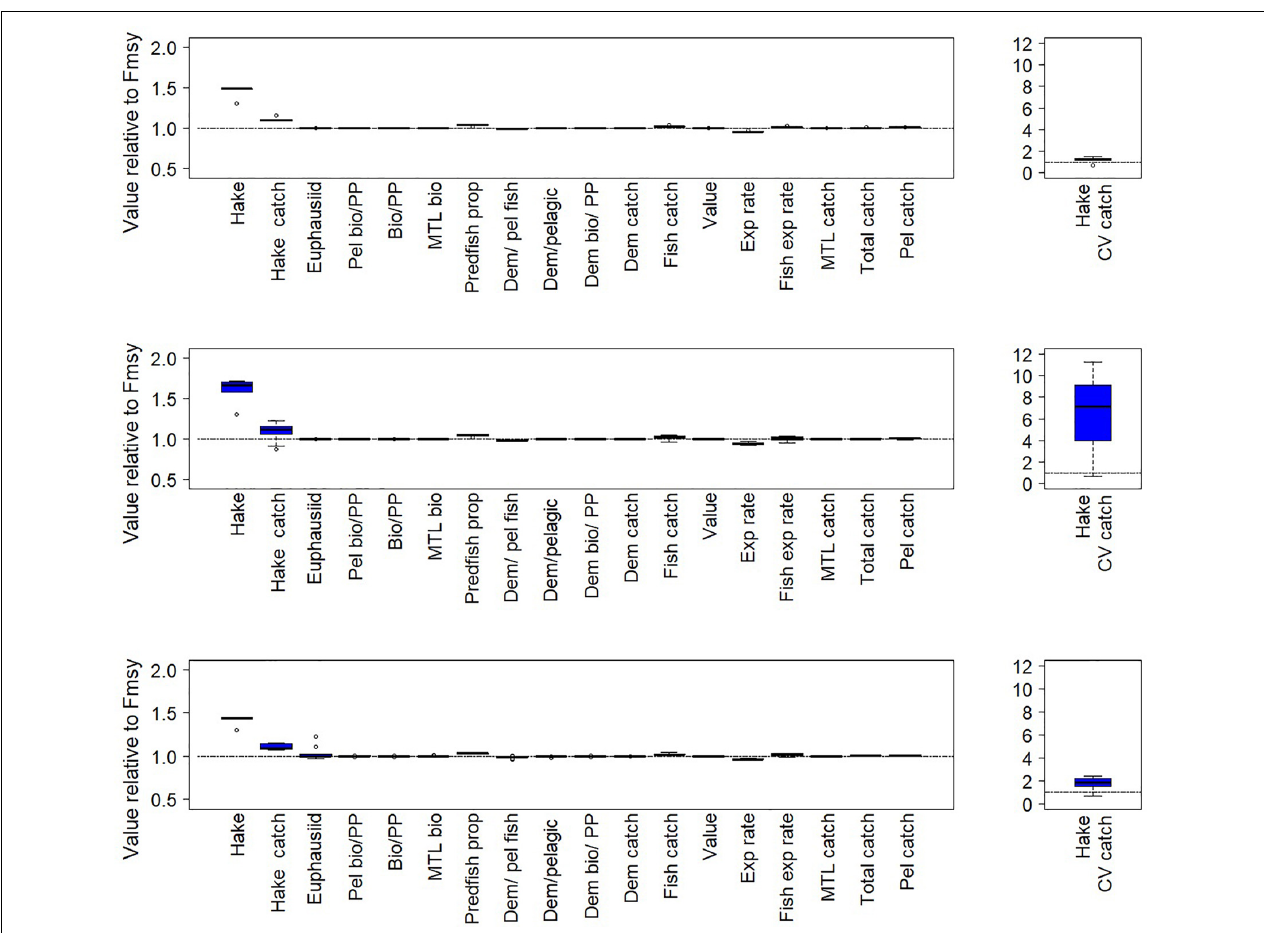
FIGURE 5 | Fishery and ecological metrics for the California Current results, with Pacific hake as target fish. These performance metrics are scored against comparable base cases with target fish F = F MSY . Each of the pairs of simulations here is forced with a different time series of euphausiid biomass. Top left panel: Performance metrics for simulations with a simple threshold harvest control rule (rule #2 in Table 1 ). Middle left panel: Performance metrics for a threshold rule for target fish that decreases fishing if productivity declines (if zooplankton < 25%). This threshold rule is #4 in Table 1 . Bottom left panel: Performance metrics for a threshold rule for target fish that increases fishing if productivity declines (if zooplankton < 25%). This threshold rule is #6 in Table 1 . Right panels: Coefficient of variation of catch. In all panels, boxes span the lower to upper quartiles, horizontal black lines within each box represent median values, and whiskers extend to the highest and lowest values excluding outliers. Outliers are indicated by open circles, defined as points beyond 1.5 times the interquartile